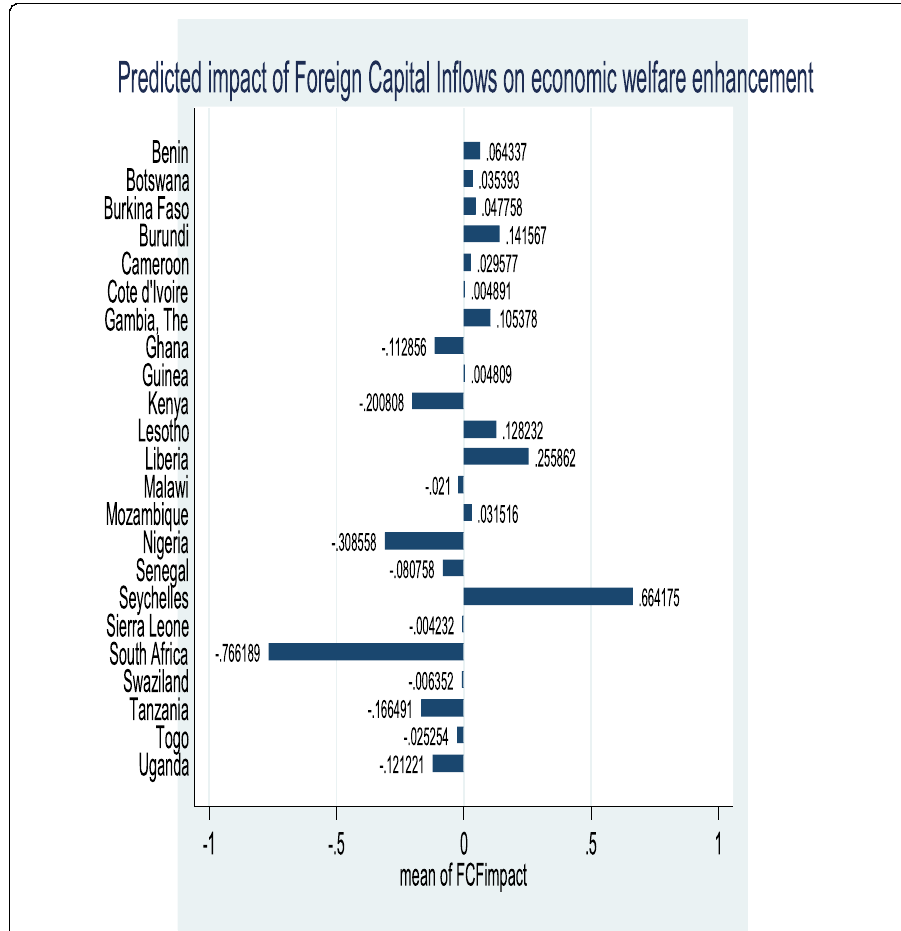
Fig. 3 FCF1: Predicted (mean) impact of FCF on economic welfare at different levels of financial development (Domestic credit as proxy for financial